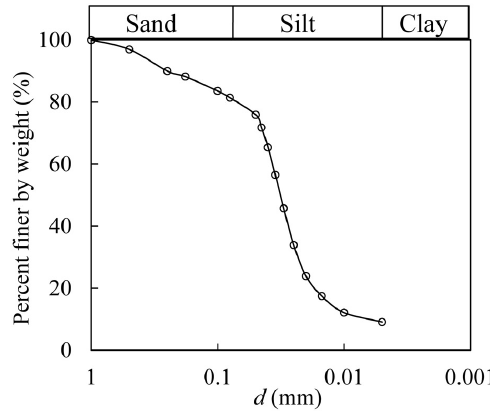
Figure 2. Grain size distribution of experiment